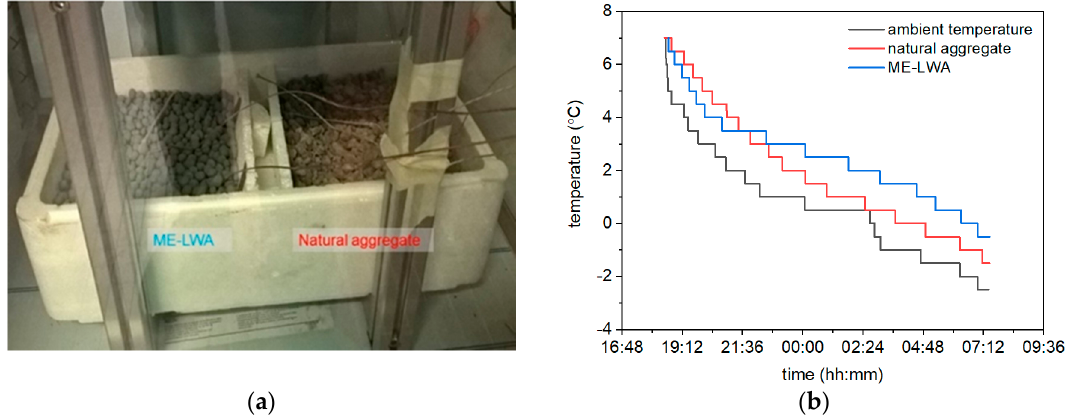
Figure 16. ( a ) Climatic chamber recording the temperature of ME-LWA and porphyry aggregates and ( b ) development of temperature versus time inside the climatic chamber.